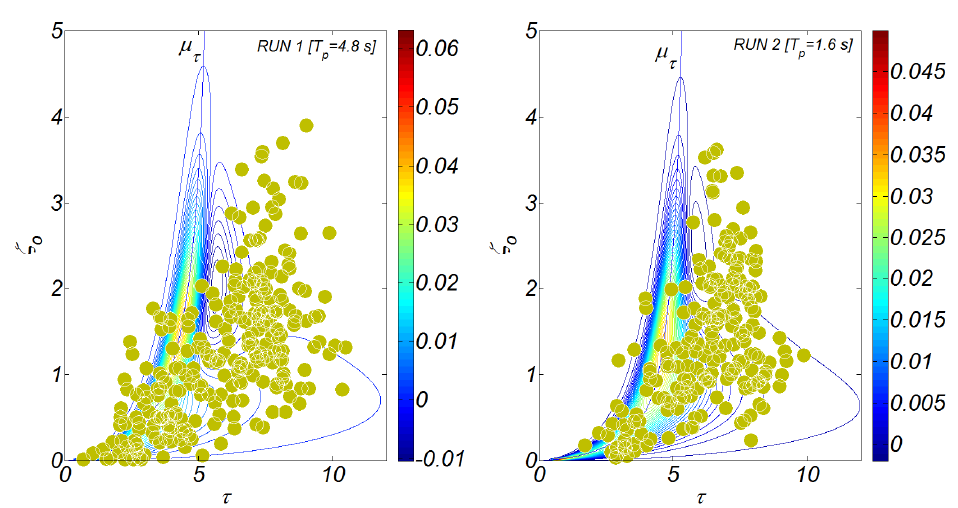
Figure 11. Comparison of joint distribution of wave crests and its associated period with measured data.